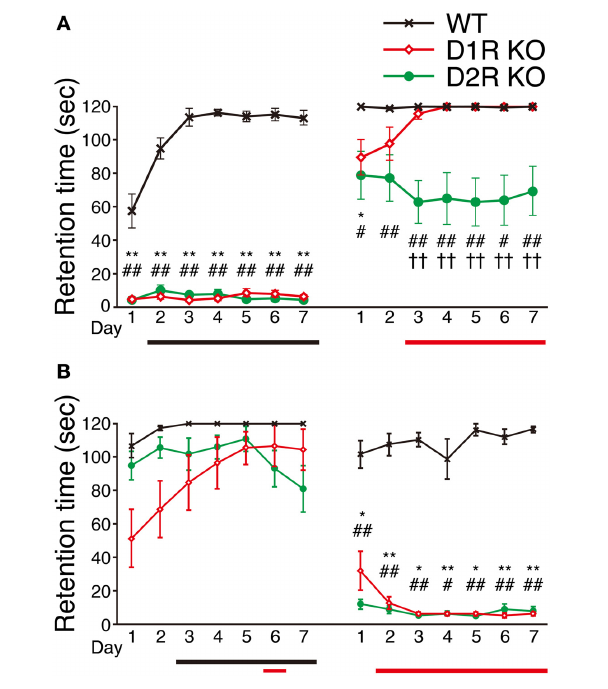
FIGURE 5 | Performance in rota-rod task. The mice of each genotype were divided into two groups, (A) the fast-slow (F-S) group (fast, 15rpm; slow, 5rpm) and (B) the slow-fast (S-F) group. All the mice performed three trials per day. The retention time (sec) is represented as the mean ± s.e.m. of these three trials. WT mice (black crosses, F-S, n = 8, S-F, n = 5), D1R KO mice (red diamonds, n = 9 for each group), and D2R KO (green circles, n = 10, for each group). The maximum time of one trial was 120sec. Significant differences between genotypes were found on days marked by ∗ p < 0 . 05, ∗∗ p < 0 . 01 for D1R KO vs. WT mice; # p < 0 . 05, ## p < 0 . 01 for D2R KO vs. WT mice; †† p < 0 . 01, for D1R KO vs. D2R KO mice (Kruskal–Wallis test). Significant improvement of performances compared with the 1st day was found on days marked by horizontal bars shown under the graph ( p < 0 . 05, Dunnett test: WT, black; D1R KO, red; D2R KO,